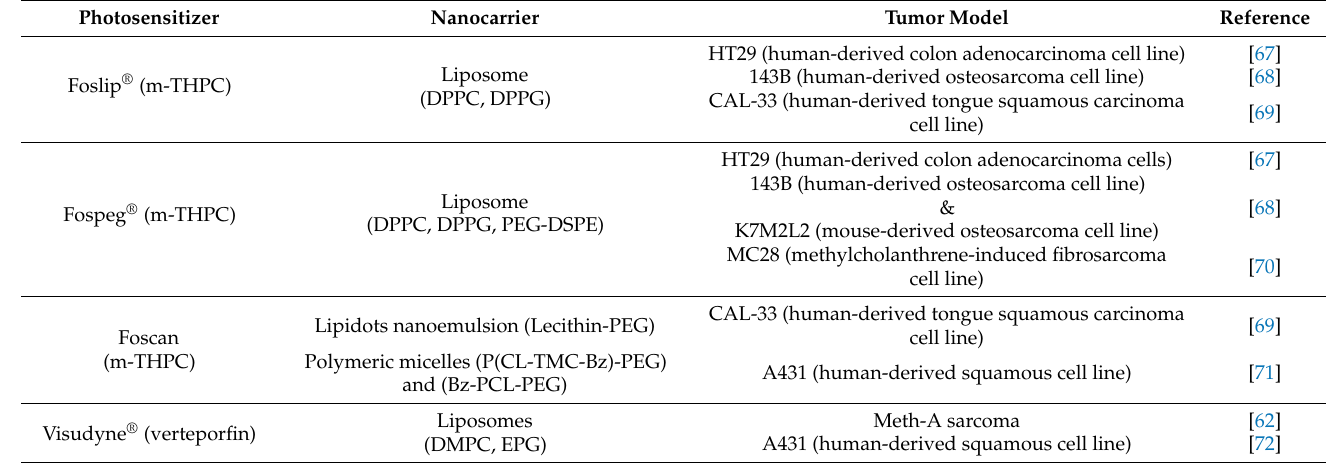
Figure 10. Self ‐ illuminating quantum dots (QDs) interacting with photosensitizer ‐ loaded micelle Figure 10. Self-illuminating quantum dots (QDs) interacting with photosensitizer-loaded micelle through BRET. Reproduced from [66]. through BRET. Adapted from [66]. Table 3. Photosensitizer ‐ loaded nanomedicine in ‐ vivo studies. Table 3. Photosensitizer-loaded nanomedicine in-vivo